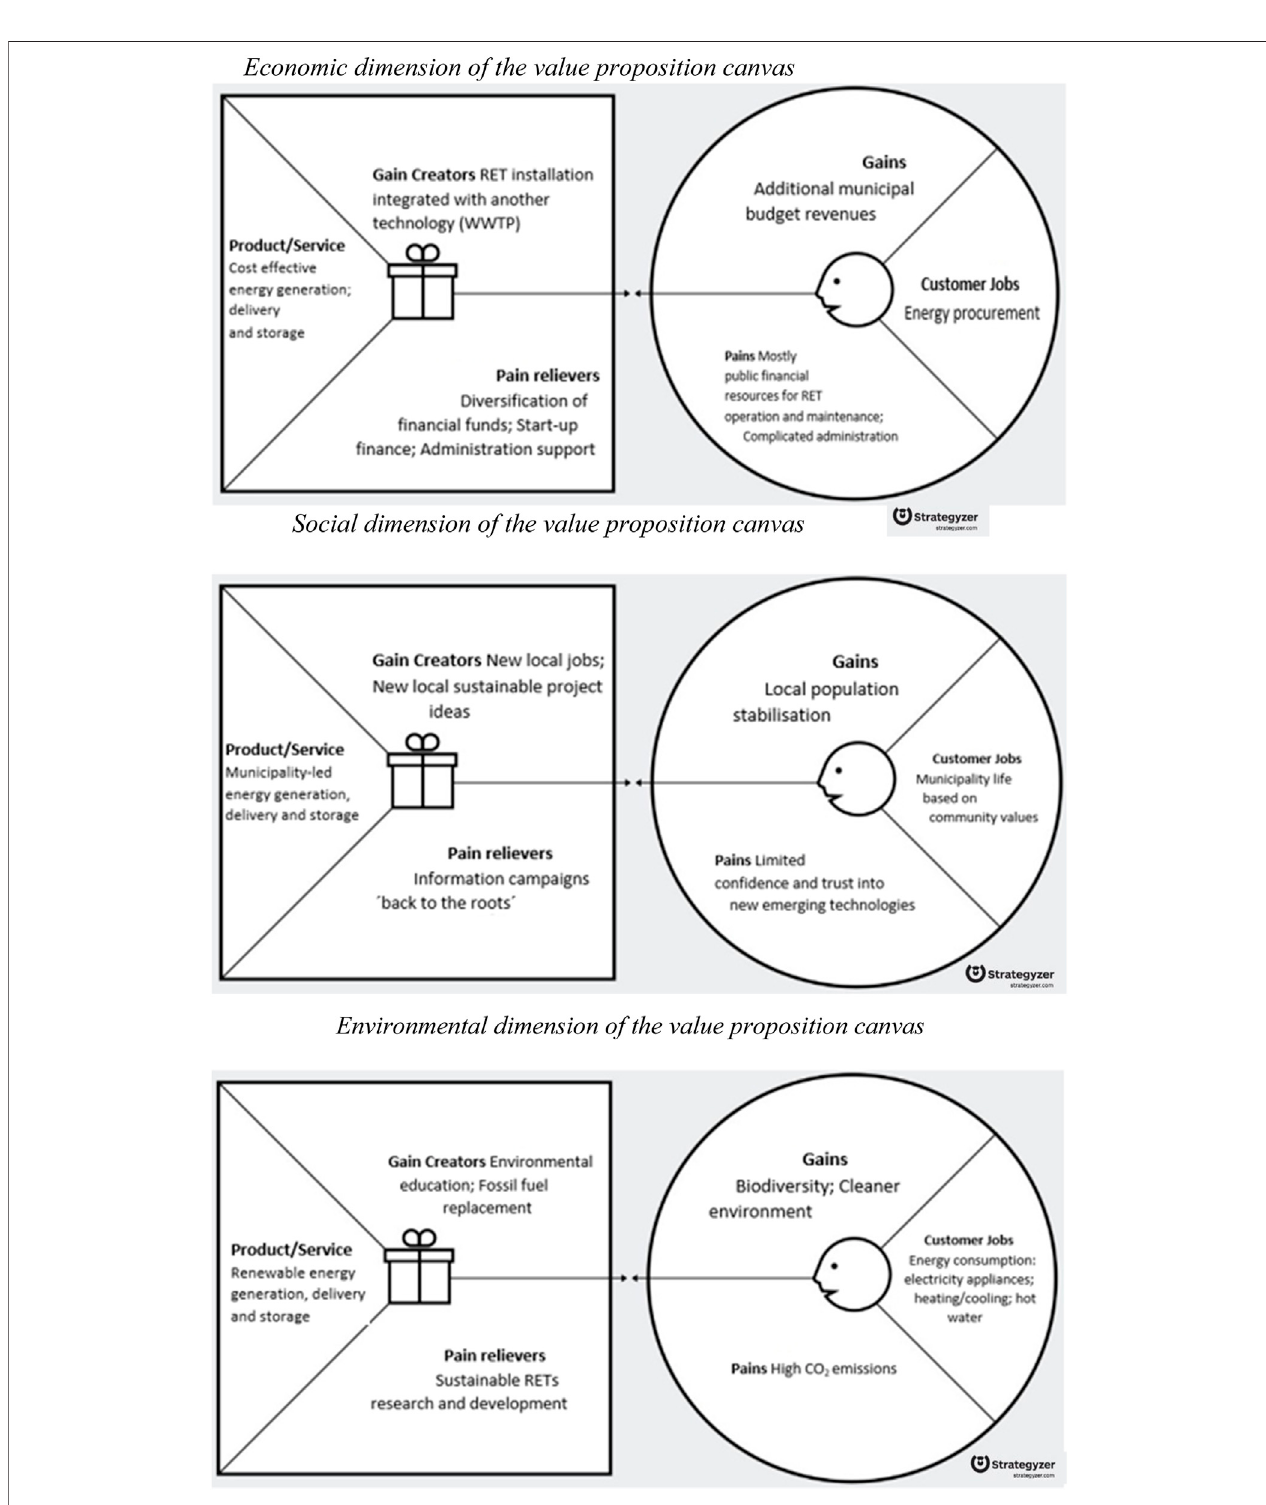
FIGURE 6 | Municipality CRE value proposition canvas based on Osterwalder et al. (2014), Strategyzer.com, and with copyright by Strategyzer AG.